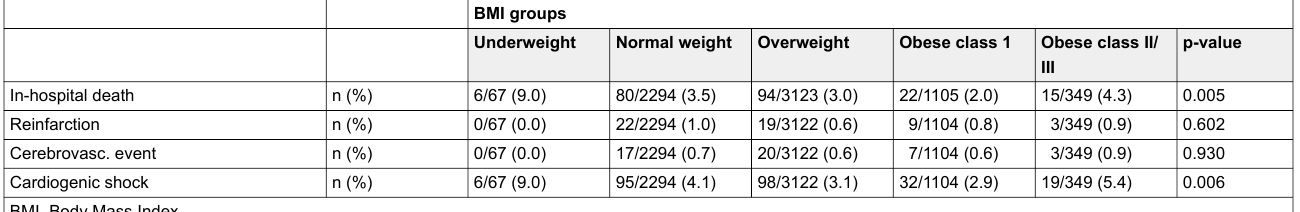
Table 2: In-hospital death and complications according to